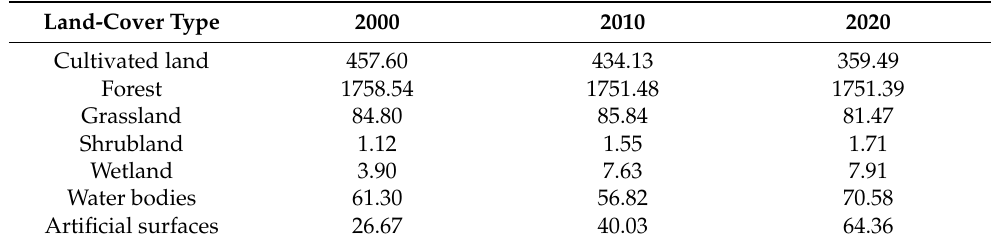
Table 9. Carbon storage of each land-cover type in Hangzhou from 2000 to 2020 (unit: 10 5 t). Land-Cover